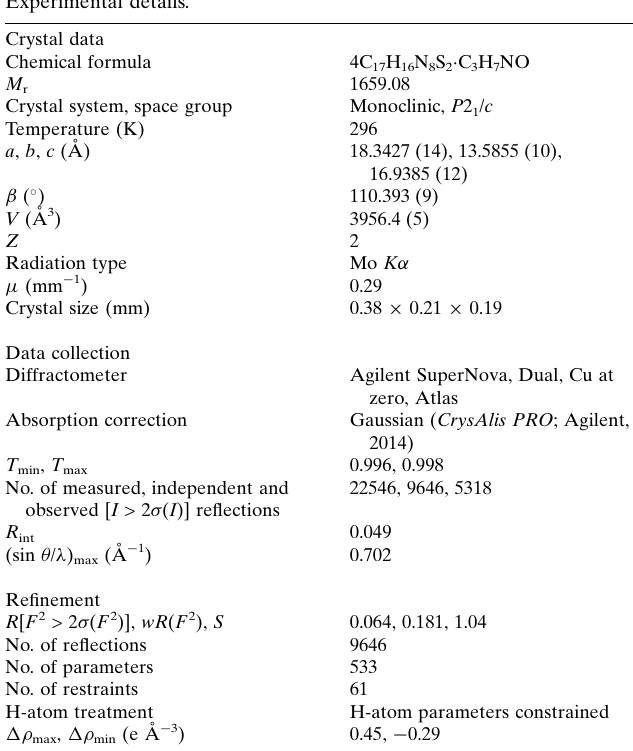
Table 2 Experimental details.